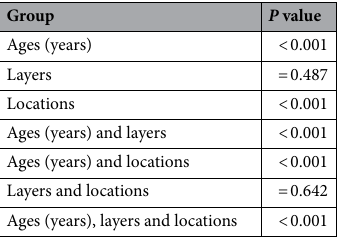
Table 4. HIT tests of between-subjects effects. R 2 = 0.78.